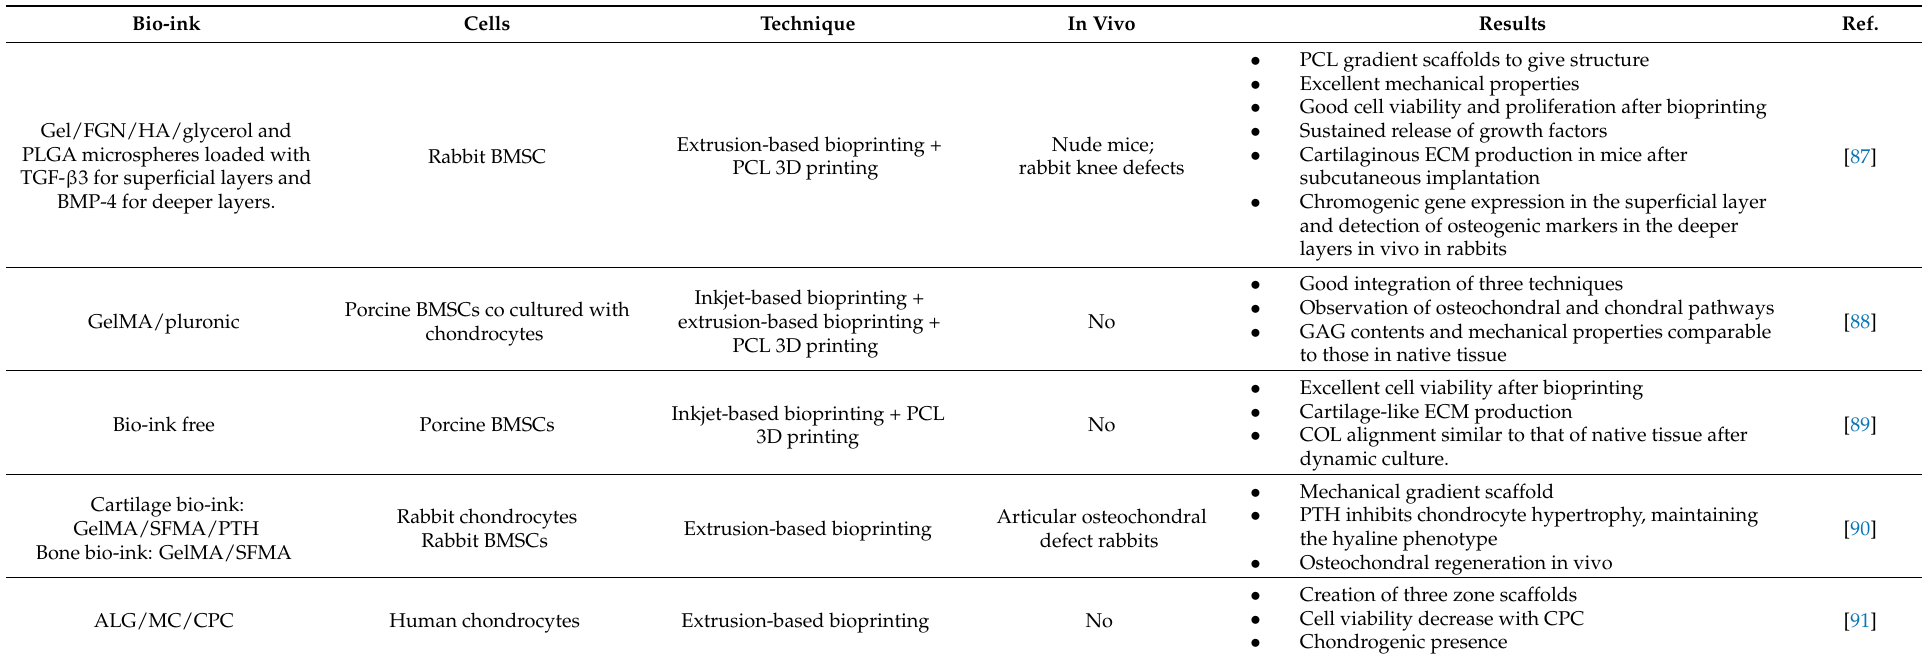
Table 4. Summary of the 3D bioprinting studies for cartilage and bone together. Bio-ink Cells Technique In Vivo Results Ref.